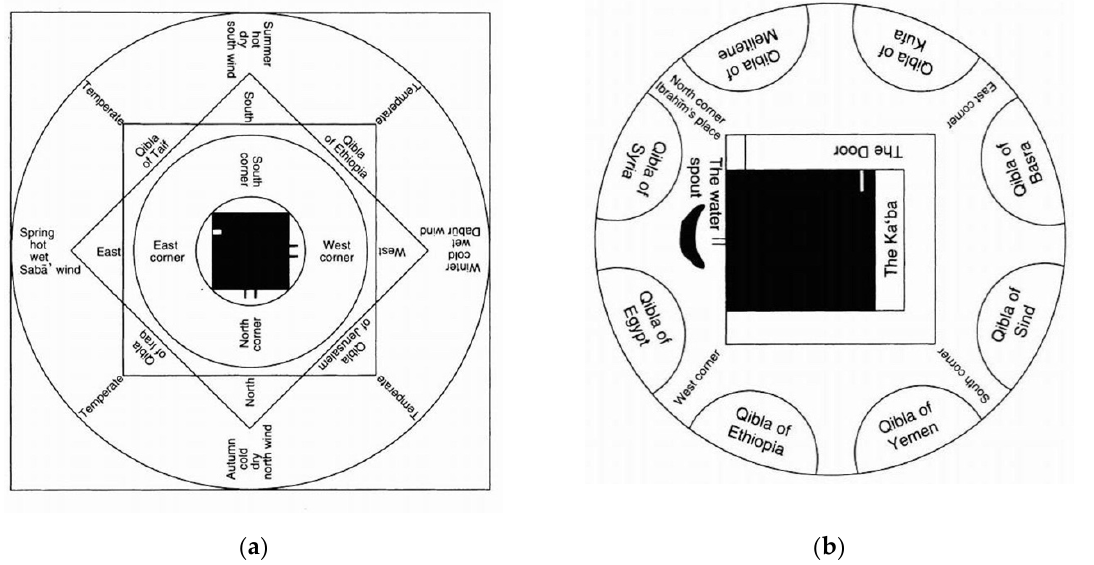
Figure 6. ( a ) Four-sector schemes of the Islamic sacred geography (King and Lorch 1992, p. 191); ( b ) eight-sector schemes of the Islamic sacred geography (King and Lorch 1992, p. 193).